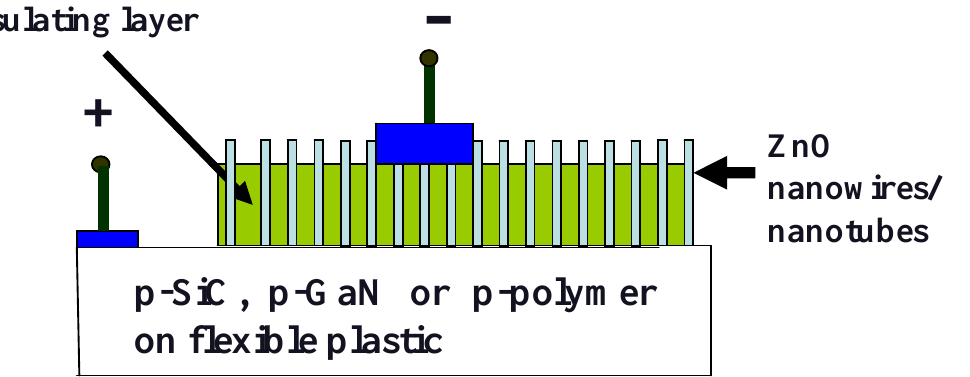
Figure 2. A schematic diagram of n-ZnO nanostructures on different p-type substrates.